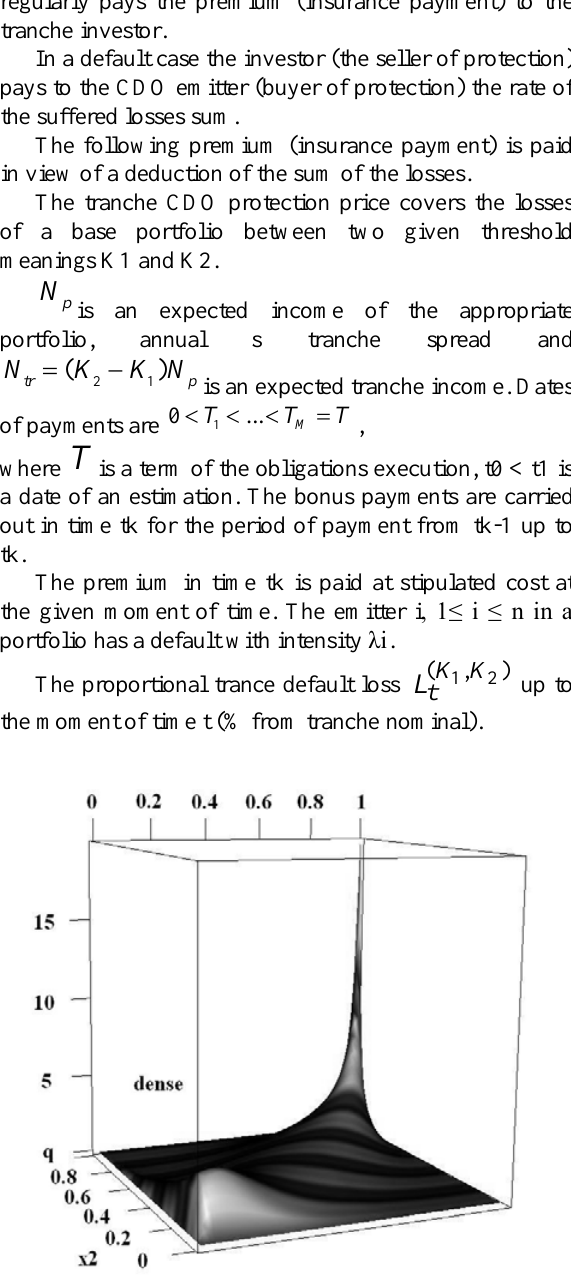
Fig. 1. GH-copula